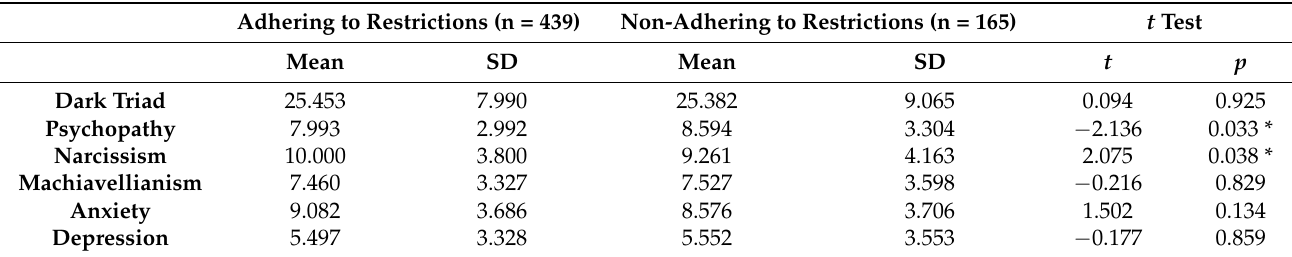
Table 3. Differences between people declaring adherence to recommendations related to restricting leaving home and those who do not.